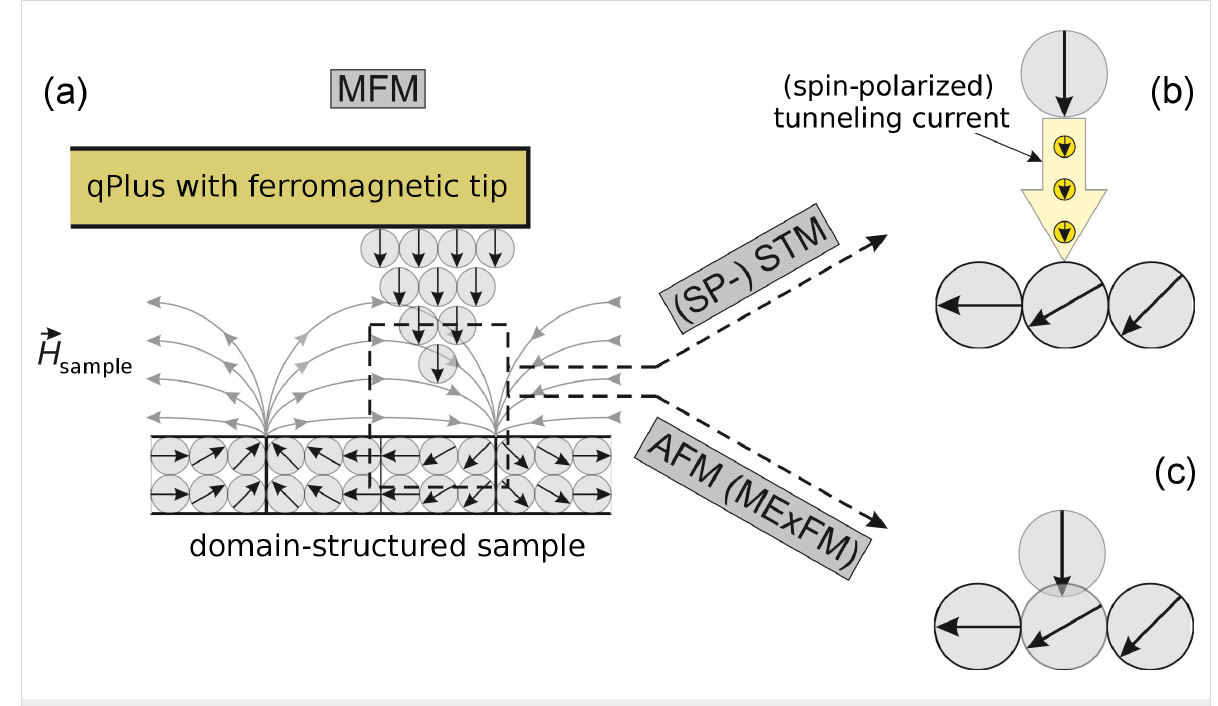
Figure 1: (a) MFM probes the force between the magnetic dipole moment of a probe tip and the magnetic stray field of a sample. With a qPlus sensor, the same probe can be used to perform (b) (SP-) STM and (c) AFM (MExFM)